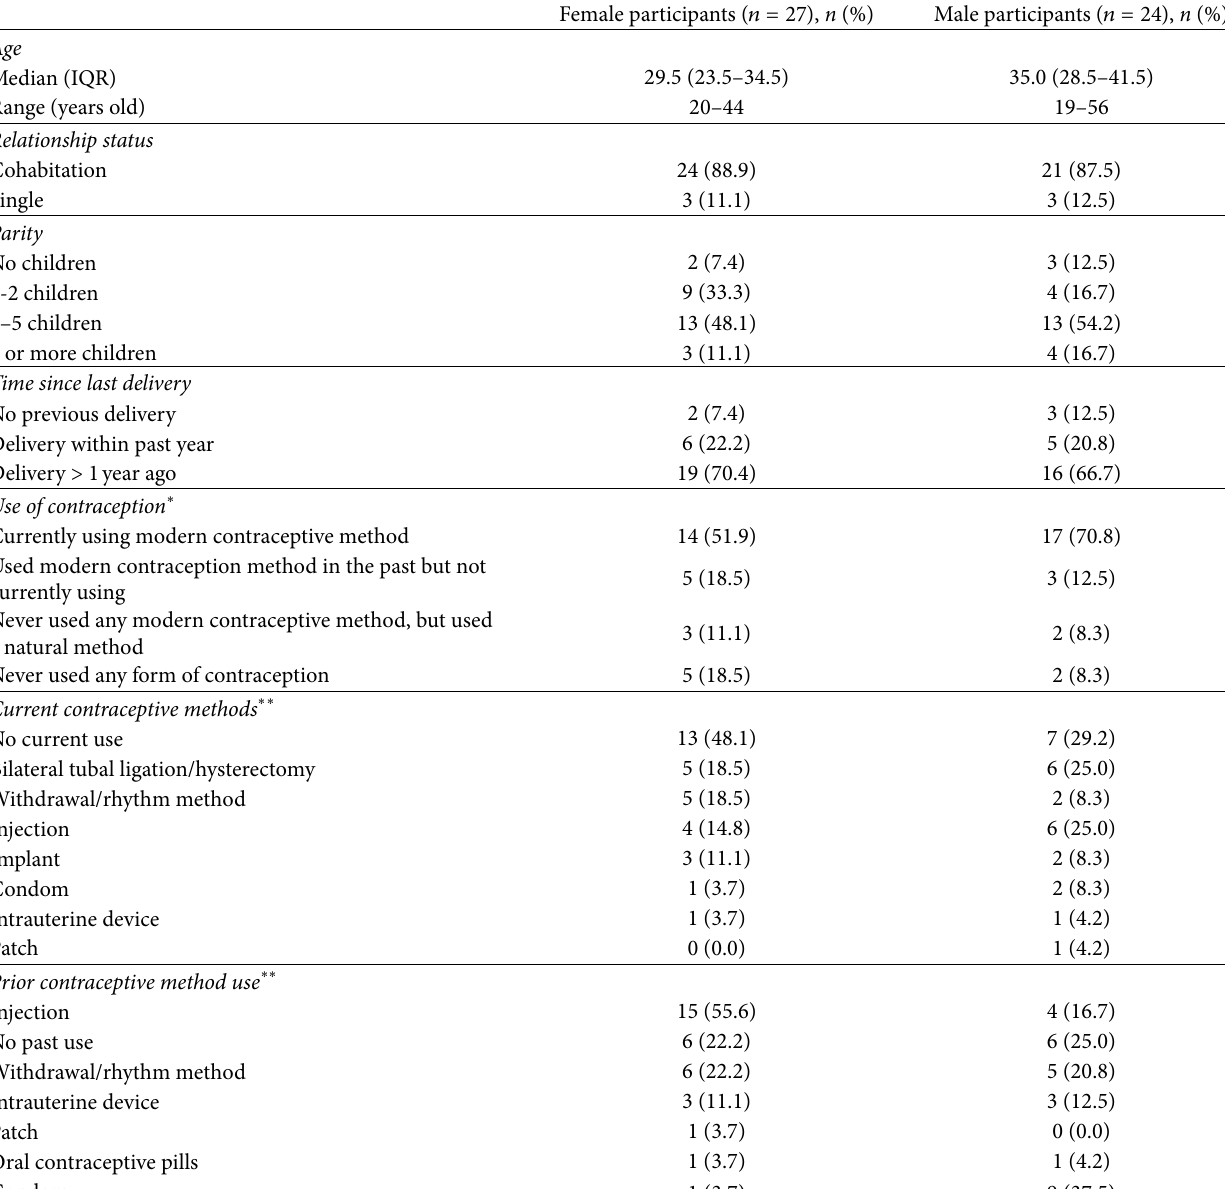
Table 3: Characteristics of community participants in qualitative in-depth